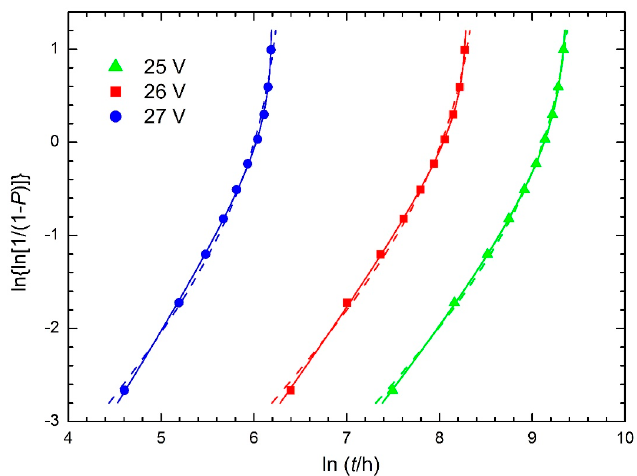
Figure 15. Weibull plots of the times to failure of a power transistor at the voltages 27 V, 26 V, and 25 V [17] for the (W4max) CDF (solid lines) and the (W3max) CDF (dashed lines). Table 5. Comparison of the sums of least squares S and the values of the t ∞ parameter in the Weibull plots of the times to failure of a power transistor at the voltages 27 V, 26 V, and 25 V [17] using the (W3min) and (W4min) CDFs.